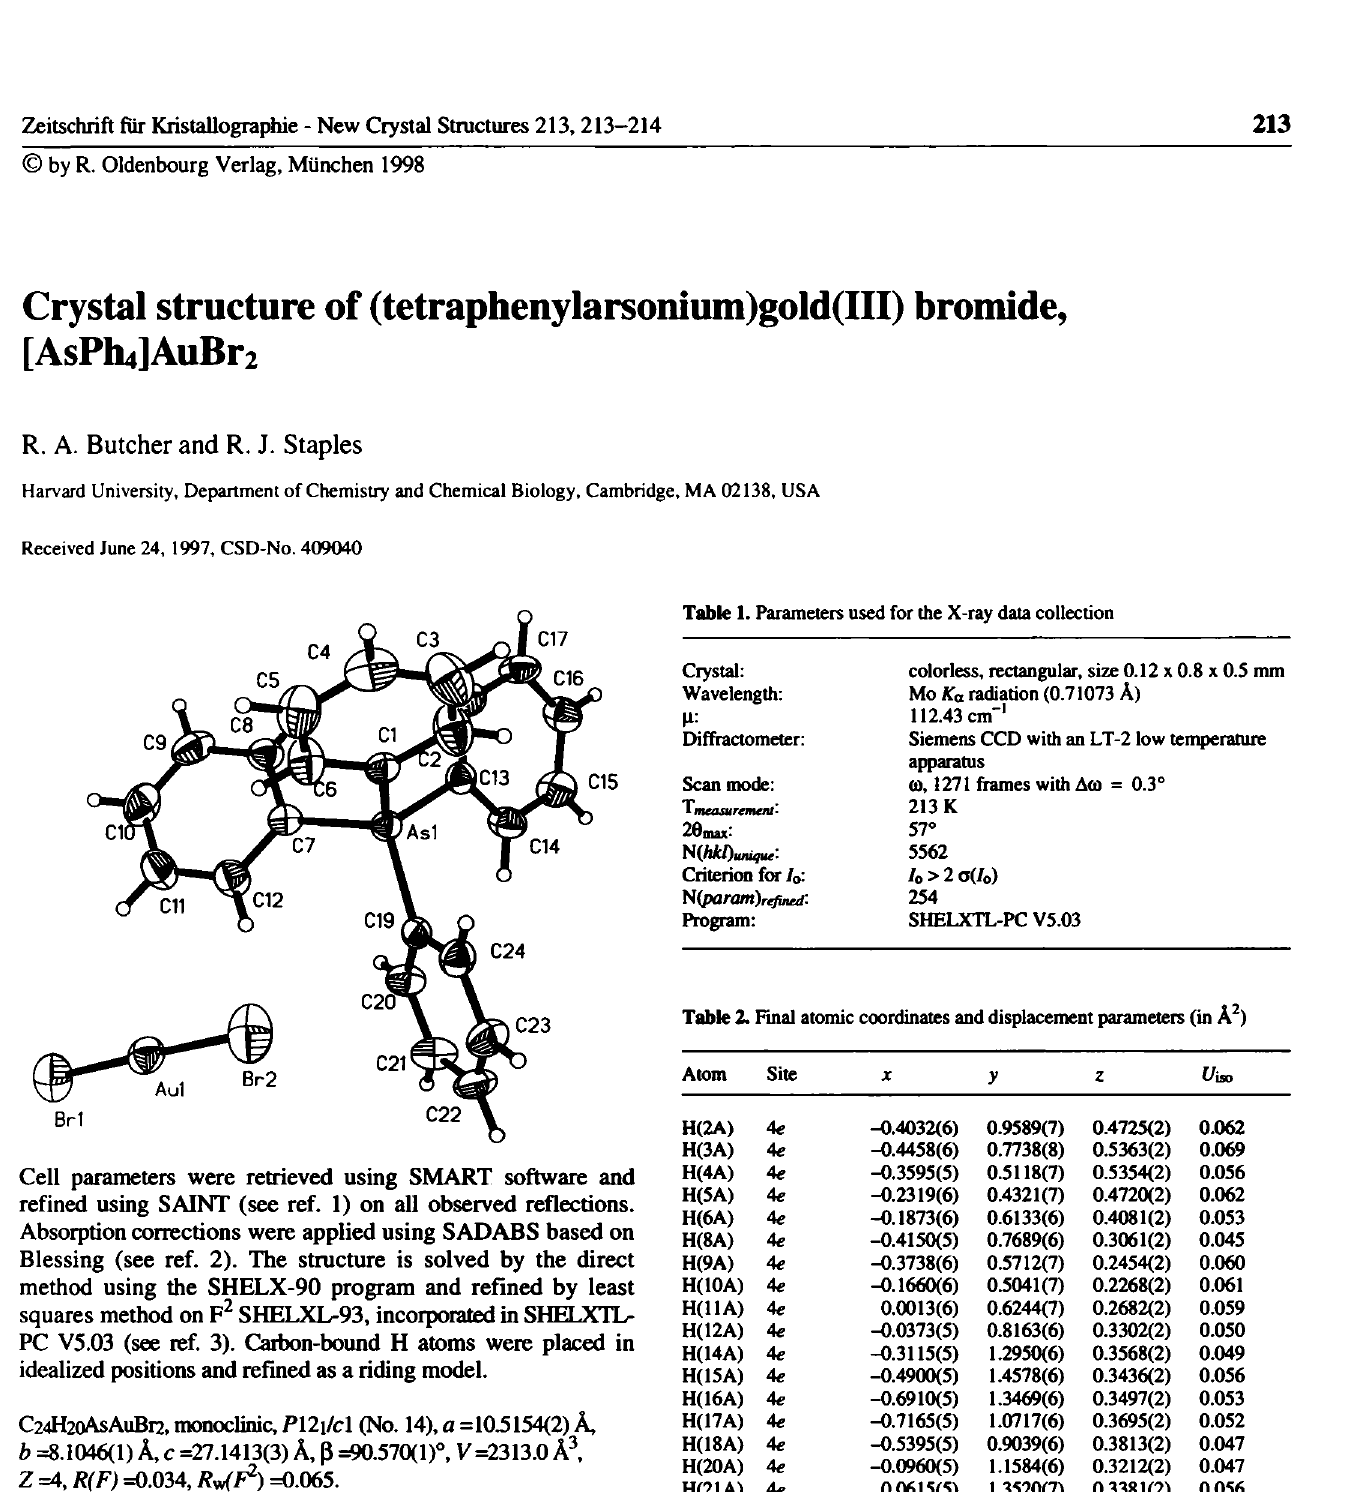
Table 3. Final atomic coordinates and displacement parameters (in Â^) Atom